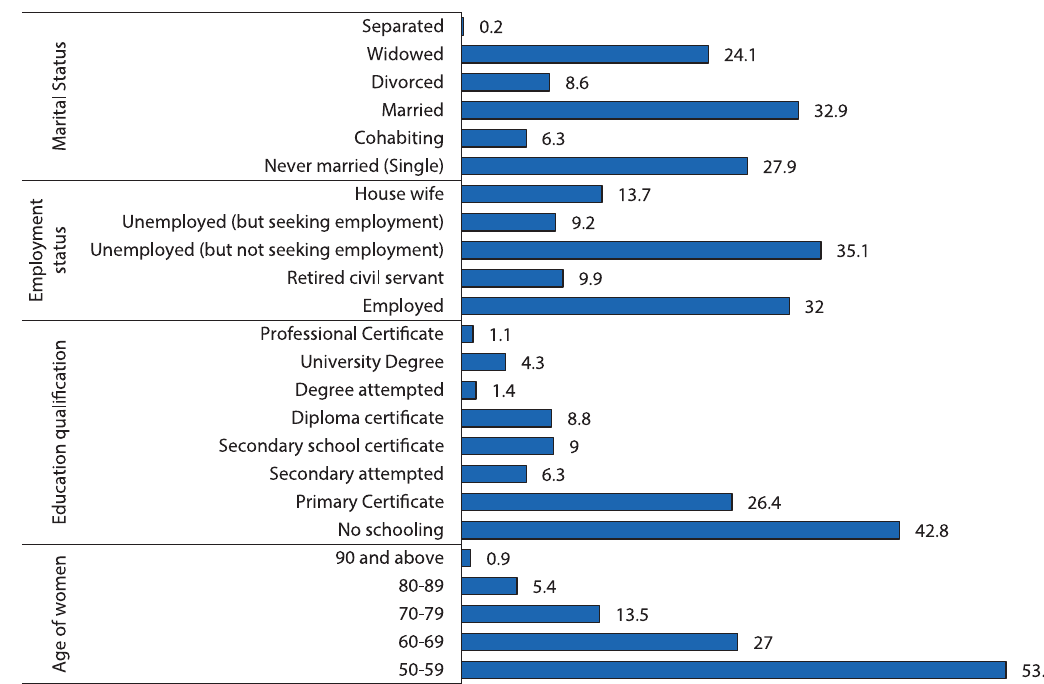
Figure 1. Characteristics of sampled older female adults.